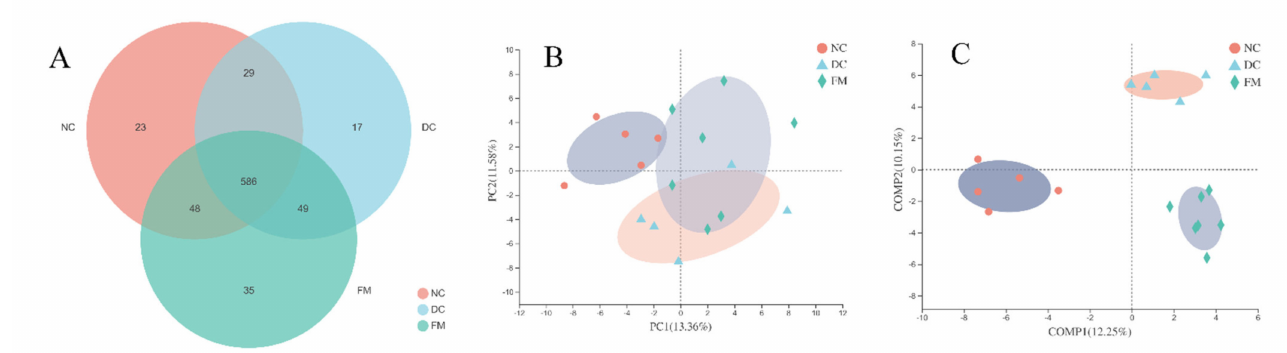
Figure 2. Effect of foxtail millet supplementation on the structure of gut microbiota: ( A ) Venn diagram on the OTU level; ( B ) unsupervised principal component analysis (PCA) on the OTU level; ( C ) supervised partial least squares discriminant analysis (PLS-DA) on the OTU level. NC, normal control group ( n = 5); DC, diabetic control group ( n = 5); FM, foxtail millet supplementation group ( n = 7).